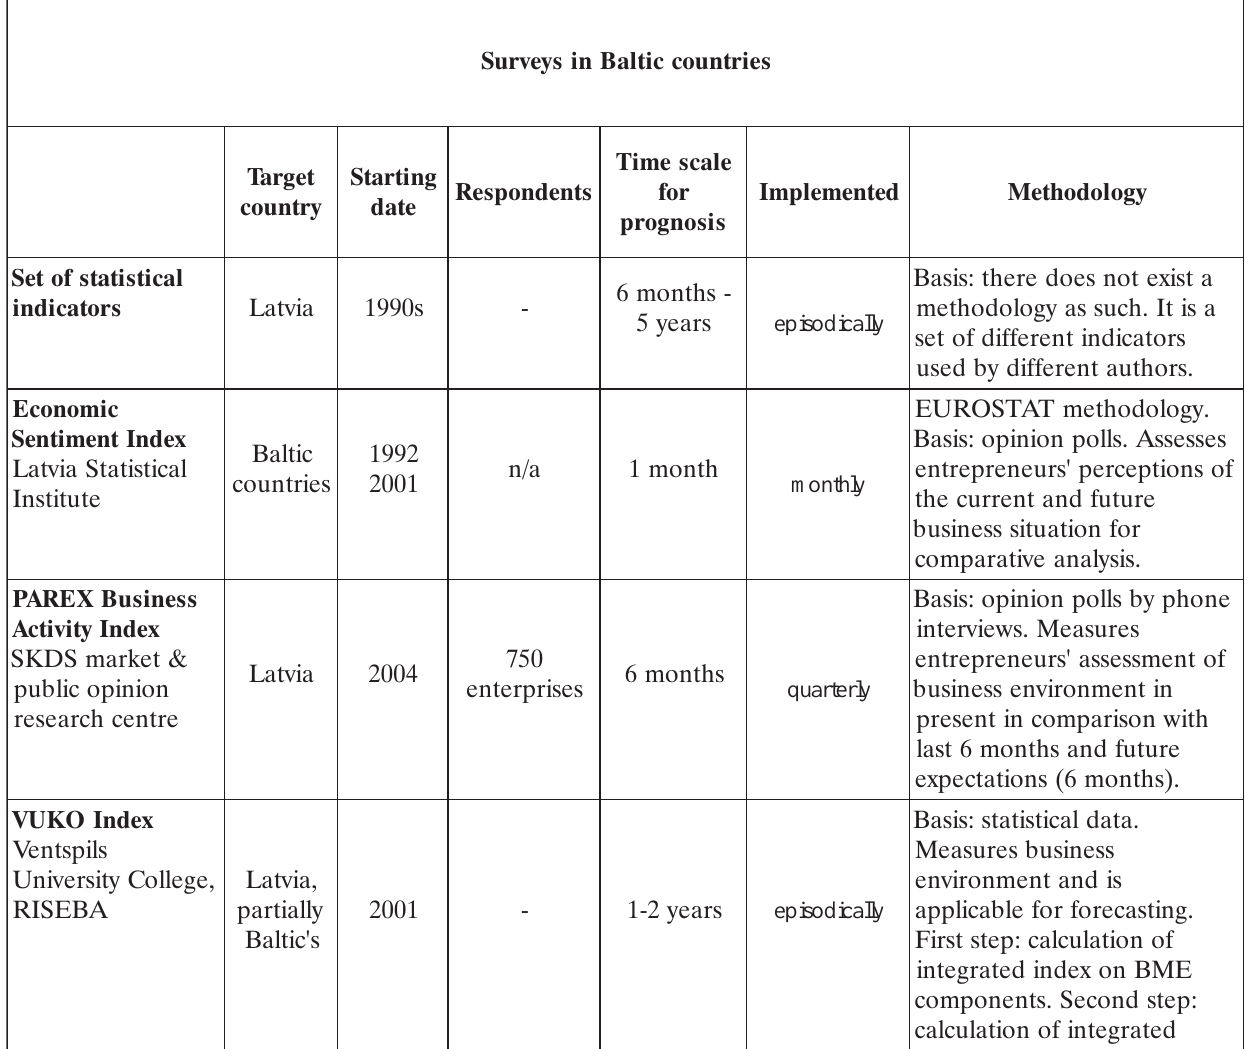
Table 2. Business climate evaluation in Baltic